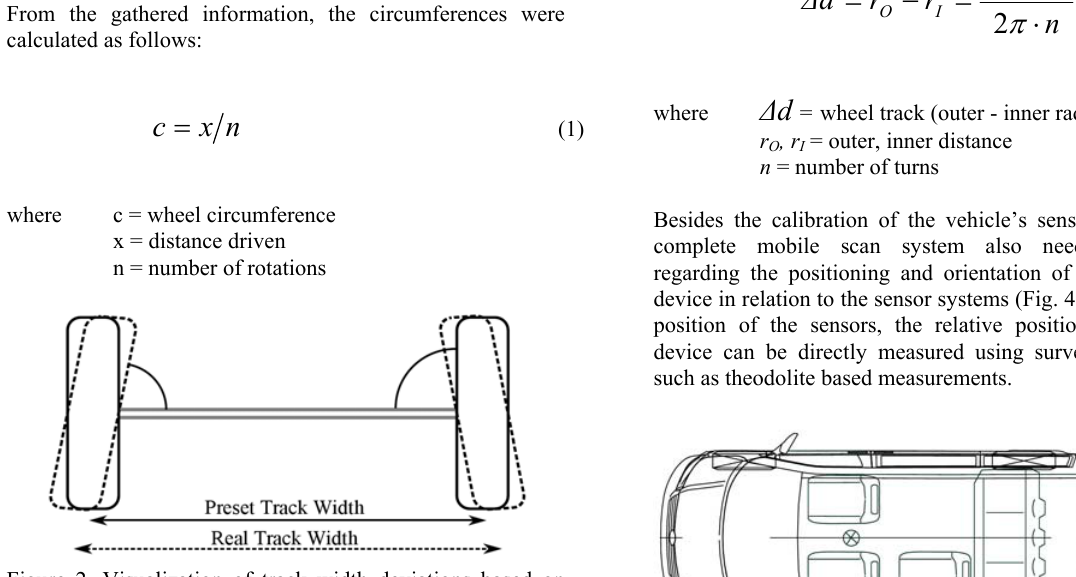
Figure 2. Visualization of track width deviations based on different wheel chambers.